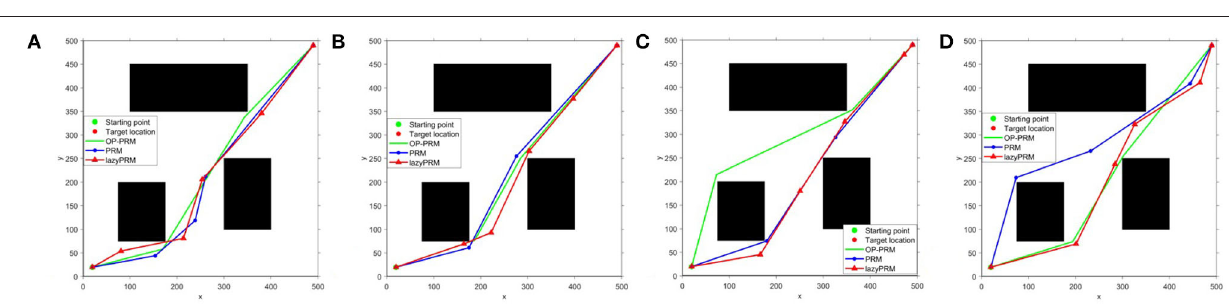
FIGURE 10 | (A–D) The performance comparison in the environments without a narrow corridor.